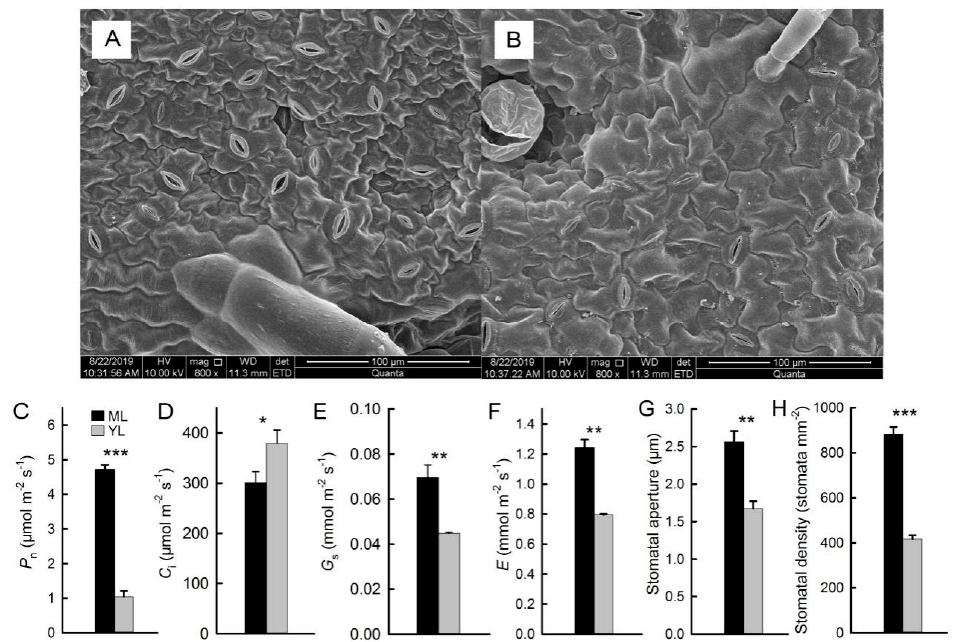
Figure 4. Stomata and gas exchange of leaves. Phenotypic characteristics of stomata in ML and YL ( A , B ). The net photosynthetic rate ( P n ) ( C ), intercellular carbon dioxide concentration ( C i ) ( D ), stomatal conductance ( G s ) ( E ), and transpiration rate ( E ) ( F ) of ML and YL (n = 10). Stomatal aperture and density ( G , H ) of ML and YL (n = 5). The error bars represent standard errors for ten biological replicates. Asterisks indicate different significant differences (* P < 0.05, ** P < 0.01, *** P < 0.001) according to two-sided Student’s t -tests.